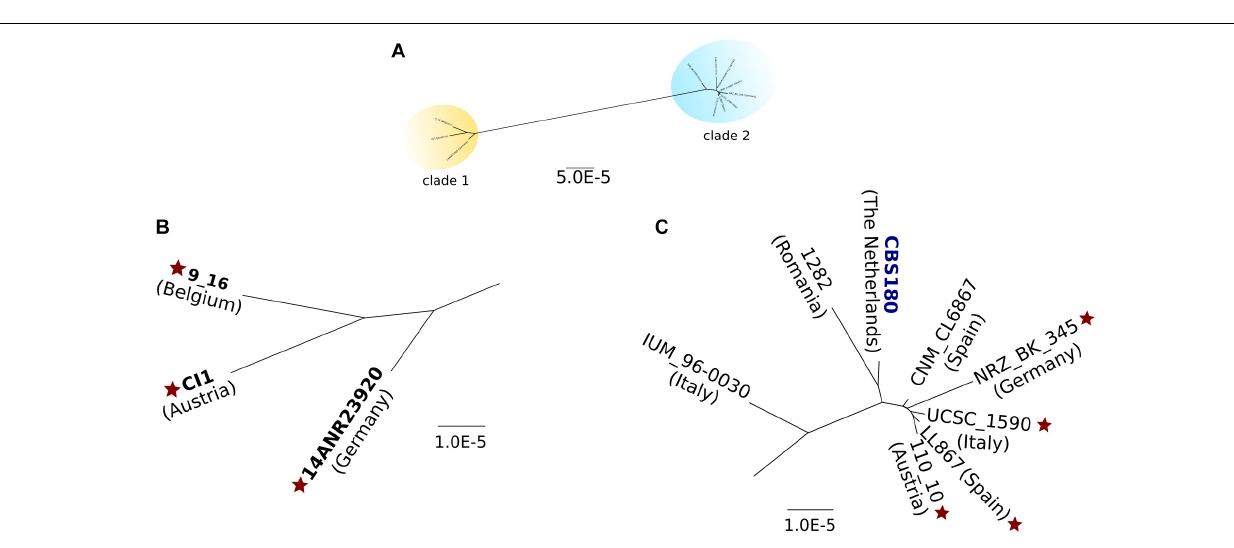
FIGURE 3 | Maximum likelihood phylogeny of all C. inconspicua strains. A concatenated alignment of 9,971,439 bp was used to reconstruct this phylogeny. Positions with heterozygous variants or INDELs in at least one strain were removed from the analysis. The type strain is marked in dark blue. Diploid strains are highlighted in bold. Star indicates invasive strains. (A) Overall view of the nuclear genome phylogeny of C. inconspicua , with two distinct clades highlighted in yellow (clade 1) and blue (clade 2). (B) Closer view on C. inconspicua clade 1. (C) Closer view on C. inconspicua clade